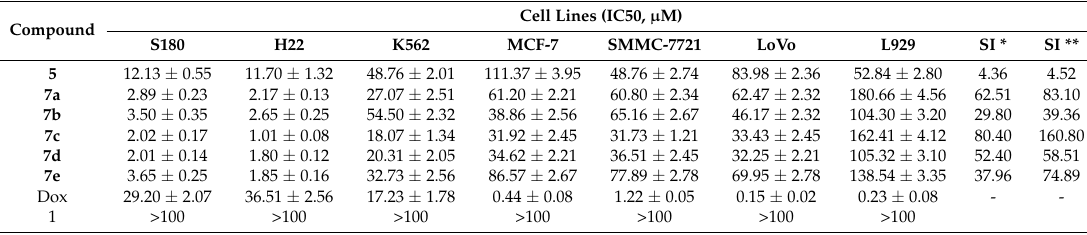
Table 1. Antitumor effect of 7a – 7e in vitro (48 h).